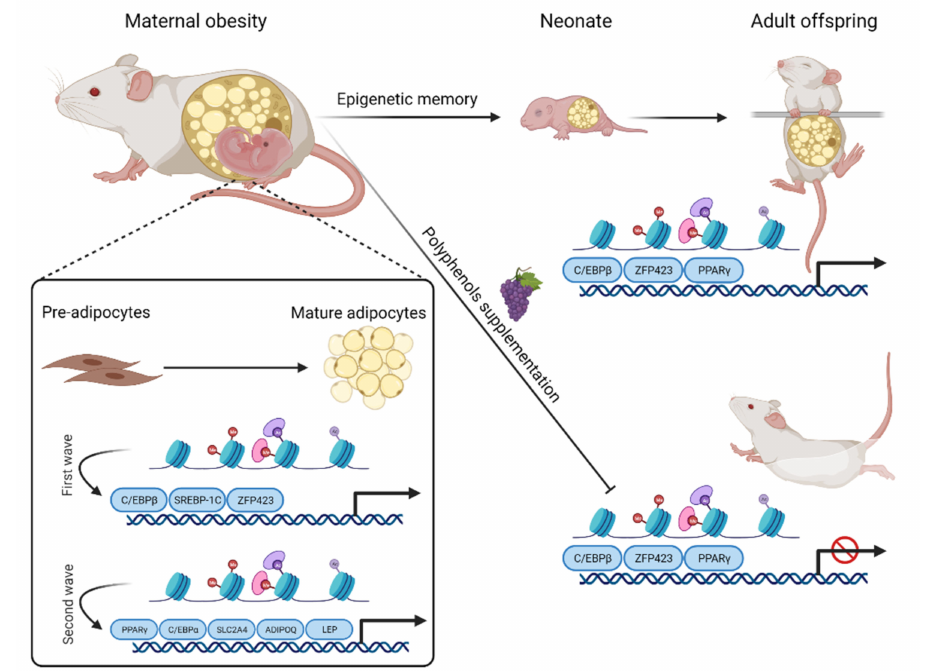
Figure 2. Schematic representation of polyphenol effect on obesity-induced maternal programming. The recruitment of the first wave of transcription factors (C/EBP β , SREBP-1C, and ZFP423) take place during adipocyte differentiation, leading to the conversion of the histone bivalent state to an active state. These transcription factors, in turn, promote an open state of chromatin in regions containing genes involved in the second wave of transcription factors, among which PPAR γ and CEBP α stand out. The second wave of transcription factors induces the expression of pro-adipogenic genes such